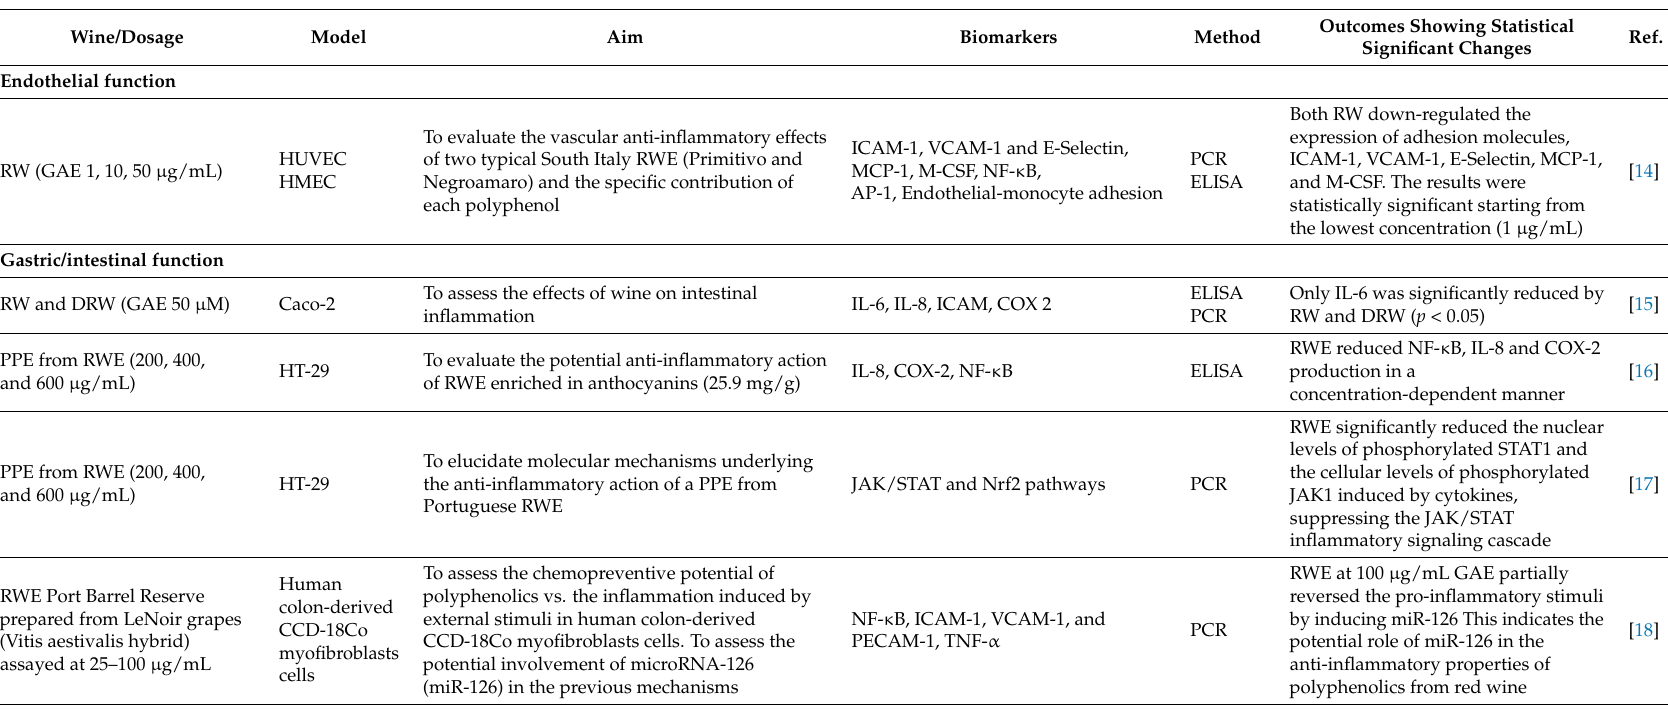
Table 1. Selected papers describing in vitro trials describing the wine effects on